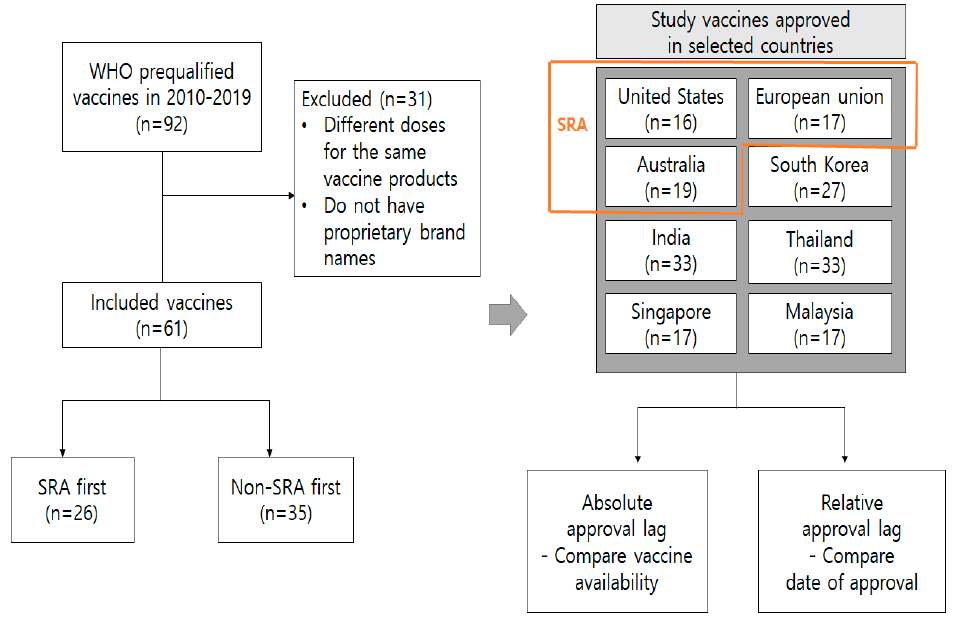
Figure 1. Flow diagram of method .